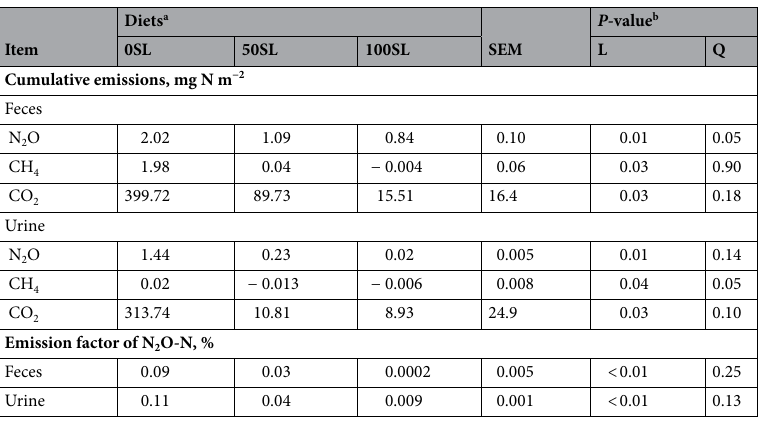
Table 2. Cumulative emissions of greenhouse gases and emission factor of N 2 O-N from feces and urine of beef steers fed three levels of inclusion of sericea lespedeza [SL; Lespedeza cuneata (Dum. Cours.) G. Don]. a 0SL: 0% inclusion sericea lespedeza hay (100% bermudagrass); 50SL: 50% inclusion sericea lespedeza hay; 100SL: 100% inclusion sericea lespedeza hay (0% bermudagrass hay). b BG × SL: bermudagrass versus sericea lespedeza hay inclusion; L: linear effect of SL inclusion; Q: quadratic effect of SL